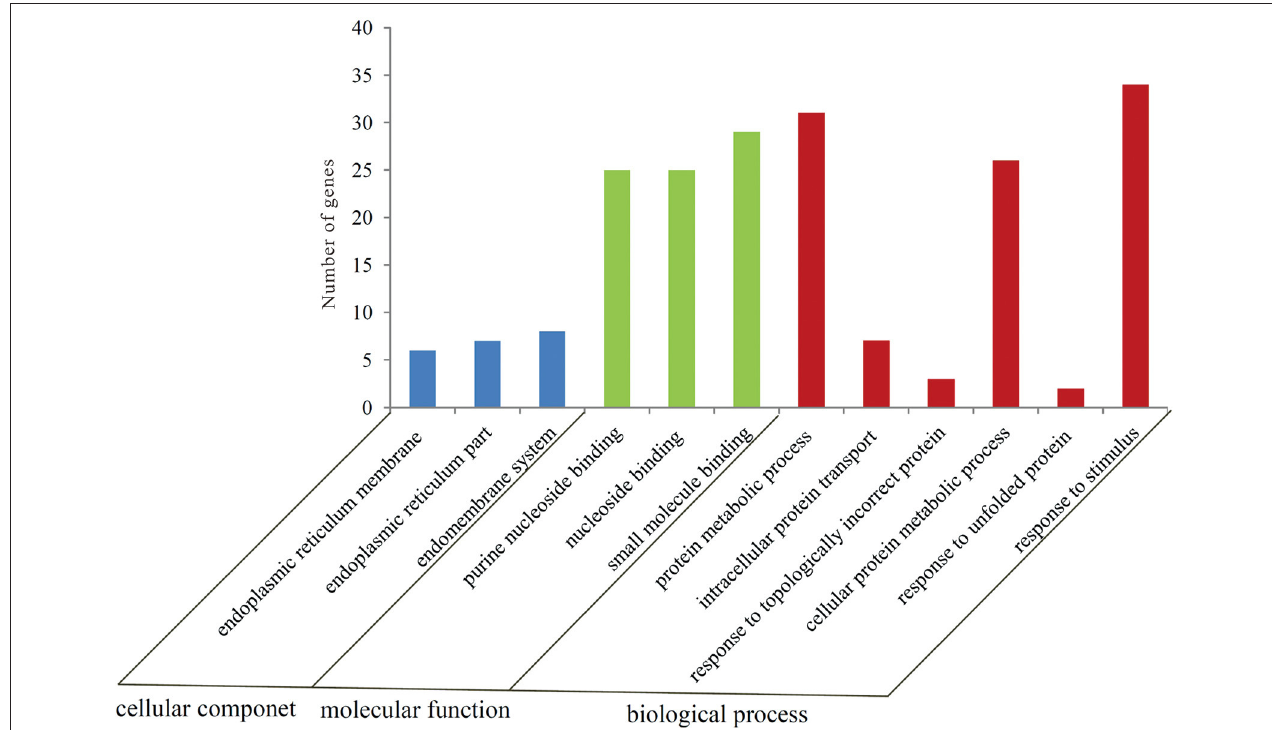
FIGURE 2 | Number of genes in each GO category as found from the Gene Ontology classification of DEGs in the thermally stressed oysters. The results are summarized in three major categories: biological process, cellular component and molecular function.